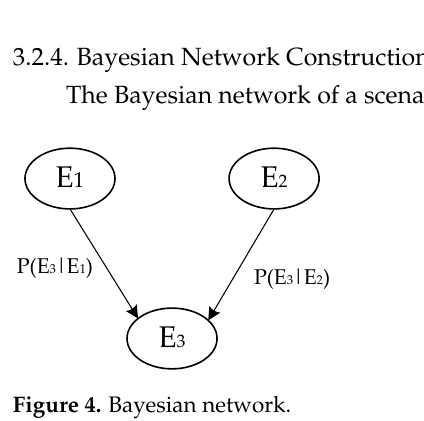
Figure 3. Relationship of scenario elements of water environmental emergencies.